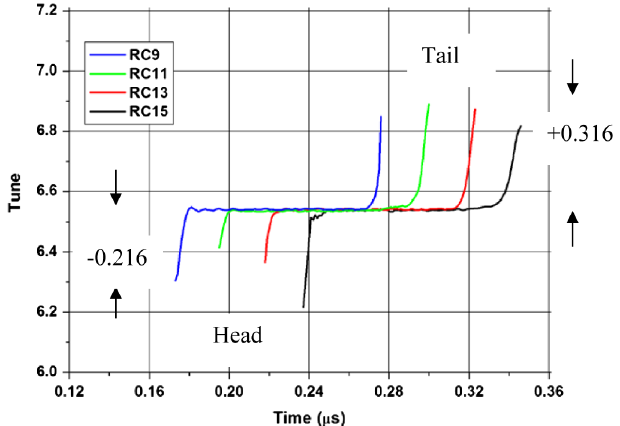
FIG. 8. Horizontal tune as a function of beam length, measured using a single beam position monitor at RC9, RC11, RC13, and